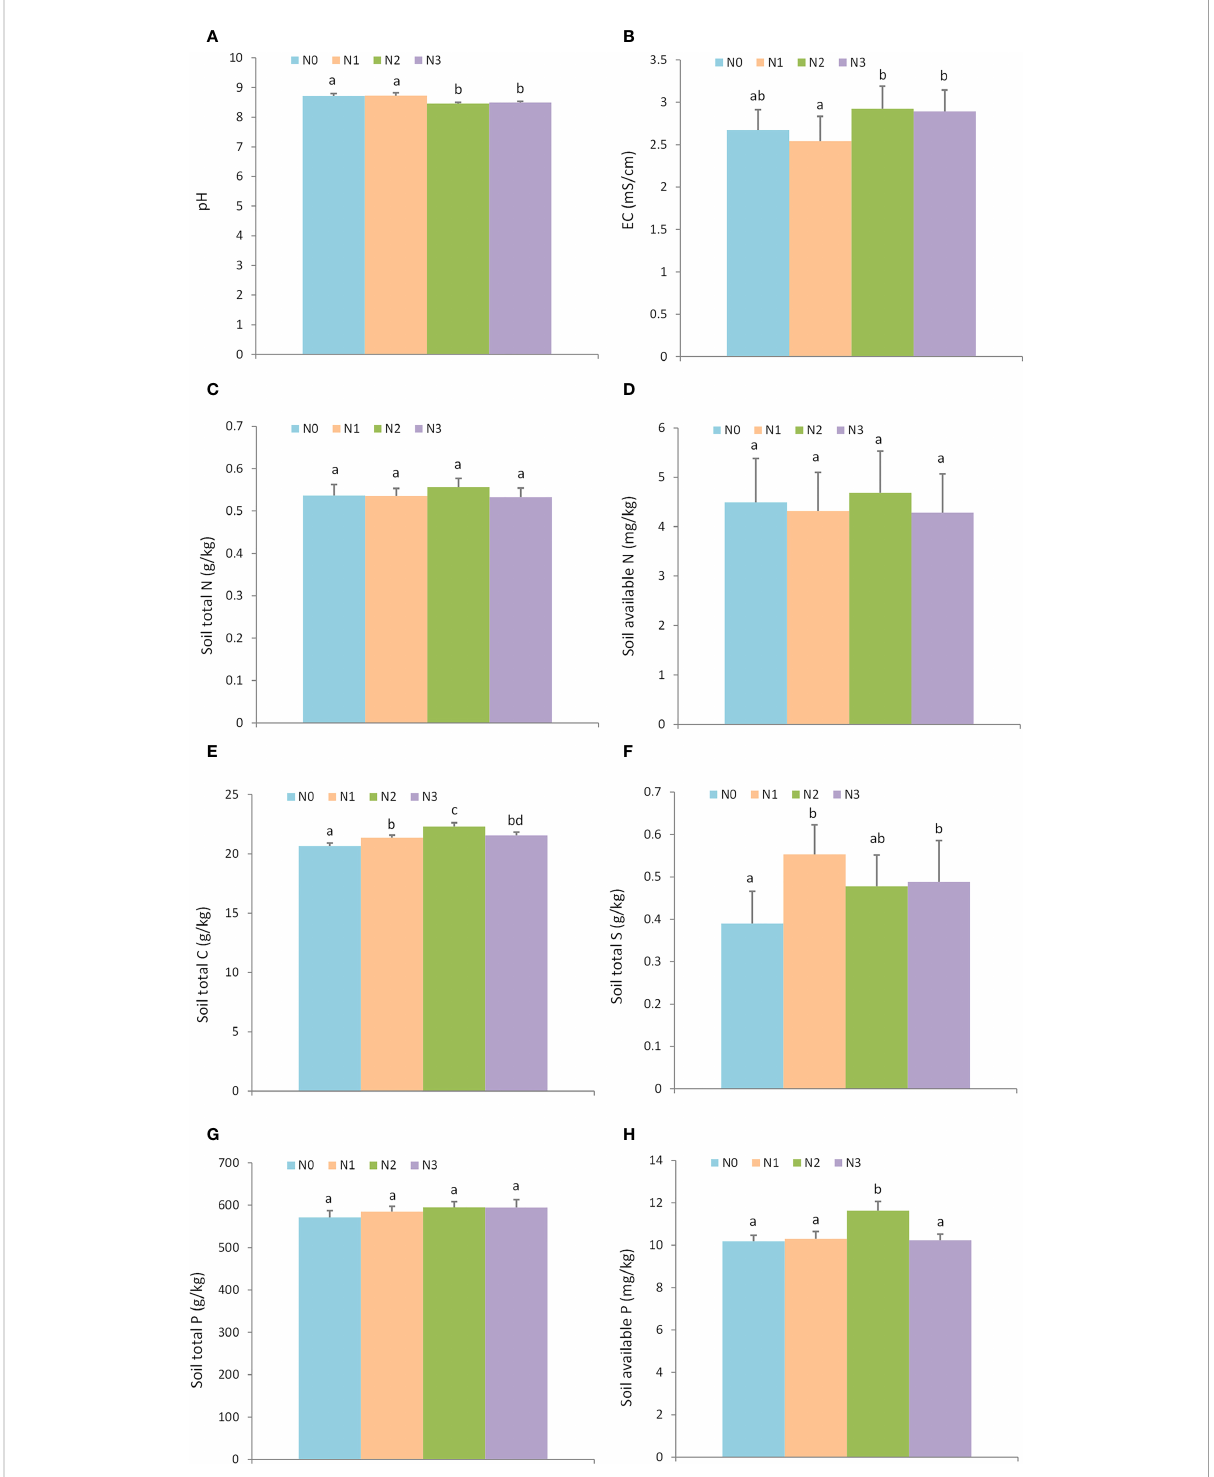
FIGURE 1 The effect of nitrogen addition on soil physical and chemical properties. N0: 0 g (cid:129) m -2 (cid:129) year -1 ; N1: 5 g (cid:129) m -2 (cid:129) year -1 ; N2: 20 g (cid:129) m -2 (cid:129) year -1 ; N3: 50 g (cid:129) m -2 (cid:129) year -1 . Different letters denote statistically signi fi cant differences. A : pH; B : EC (mS/cm); C : Soil total N (g/kg); D : Soil available N (mg/kg); E : Soil total C (g/kg); F : Soil total S (g/kg); G : Soil total P (g/kg); H : Soil available P